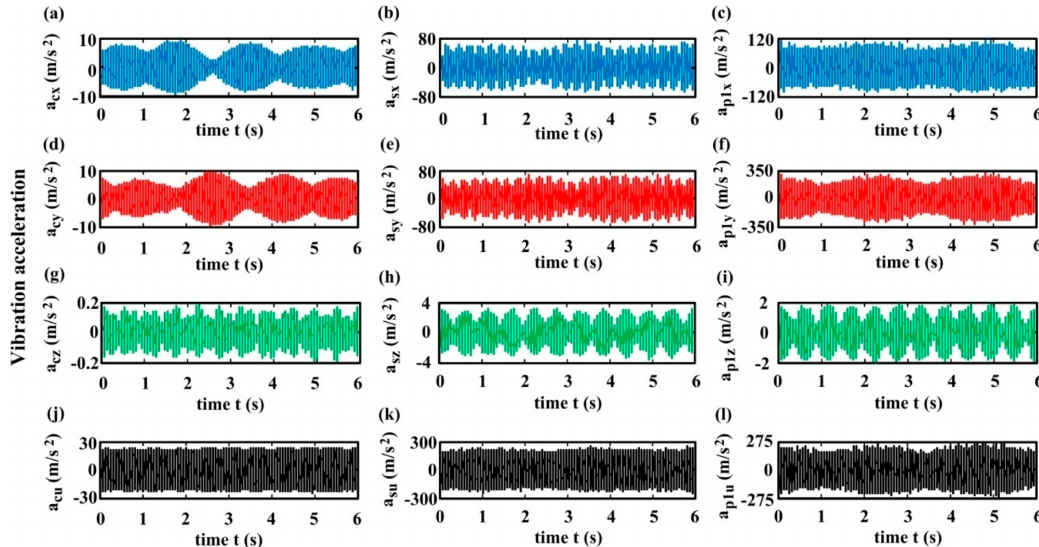
Figure 11. Variations of the vibration accelerations of the main components from the model in the presence of the planet–gear eccentric error excitation E p1 = 100 µ m with gear mesh time. ( a , d , g , j ) the carrier accelerations in x -, y -, z -, and u -directions, represented as a cx , a cy , a cz , and a cu , respectively; ( b , e , h , k ) the sun accelerations in x -, y -, z -, and u -directions, represented as a sx , a sy , a sz , and a su , respectively; ( c , f , i , l ) the planet accelerations in x -, y -, z -, and u -directions, represented as a p1x , a p1y , a p1z , and a p1u ,